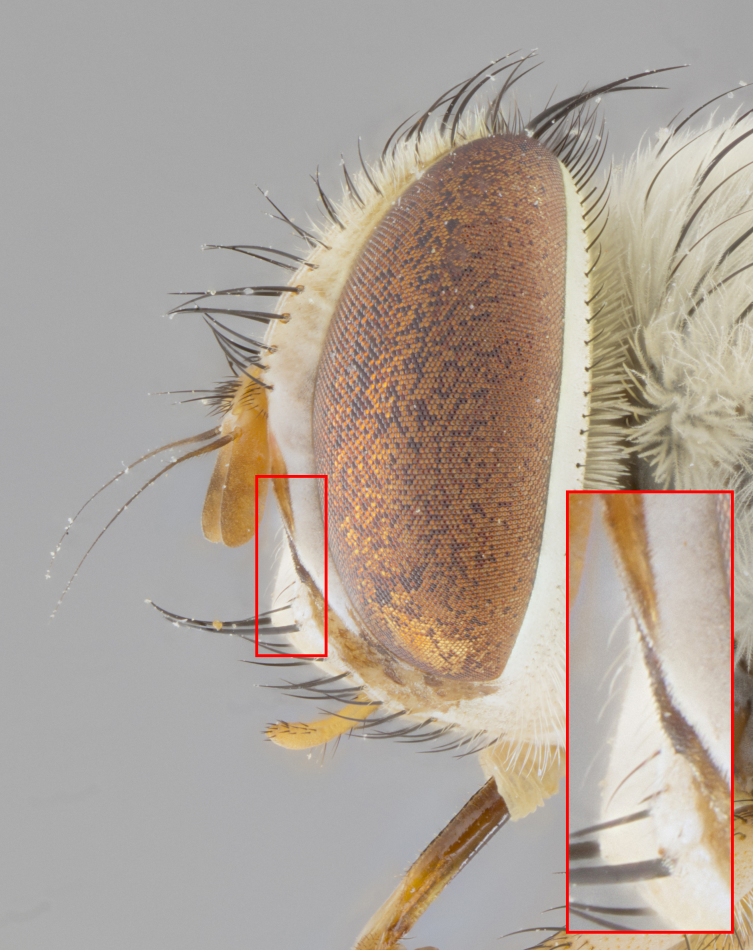
Detailed lateral view of holotype of T.
fimbriata
sp. n. male head, inset displaying characteristic pale haired facial ridge